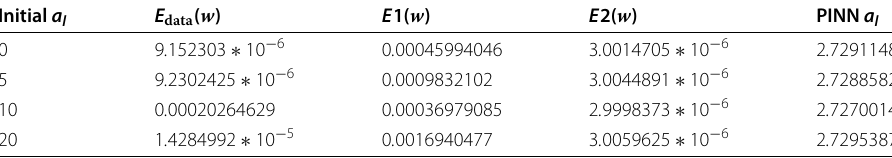
Table 1 The PINNs results for the data mean squared error and the mean squared errors corresponding to the residual functions defining the POD-Galerkin ROM DAE Initial a l E data ( w ) E 1( w ) E 2( w ) PINN a